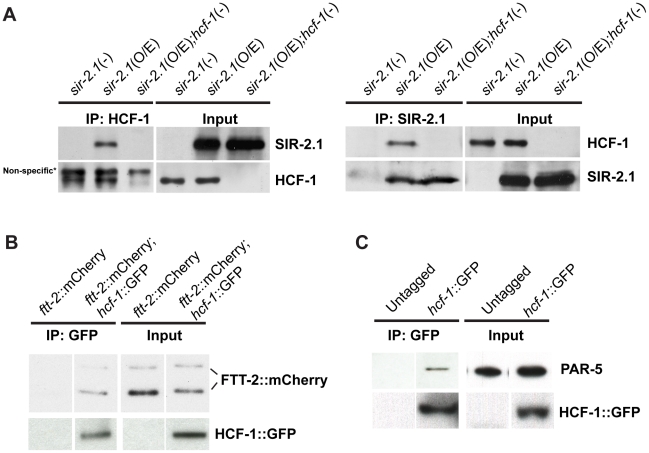

C. elegans HCF-1 physically interacts with SIR-2.1 and 14-3-3 proteins.(A) Lysates from sir-2.1(-) (sir-2.1(ok434)), sir-2.1(O/E) (geIn3[sir-2.1(O/E)]), and sir-2.1(O/E);hcf-1(-) (hcf-1(ok559);geIn3[sir-2.1(O/E)]) worms were either immunoprecipitated using anti-HCF-1 antibody (left panel) or anti-SIR-2.1 antibody (right panel). The immunoprecipitated protein complexes were subsequently immunoblotted using anti-HCF-1, or anti-SIR-2.1 antibodies. (B) Lysates from ftt-2::mCherry or hcf-1::GFP;ftt-2::mCherry were immunoprecipitated with an anti-GFP antibody and blotted with anti-mCherry or anti-GFP antibodies. (C) Wild-type or HCF-1::GFP expressing worm lysates were immunoprecipitated using anti-GFP antibodies and blotted with anti-PAR-5 or anti-GFP antibody.